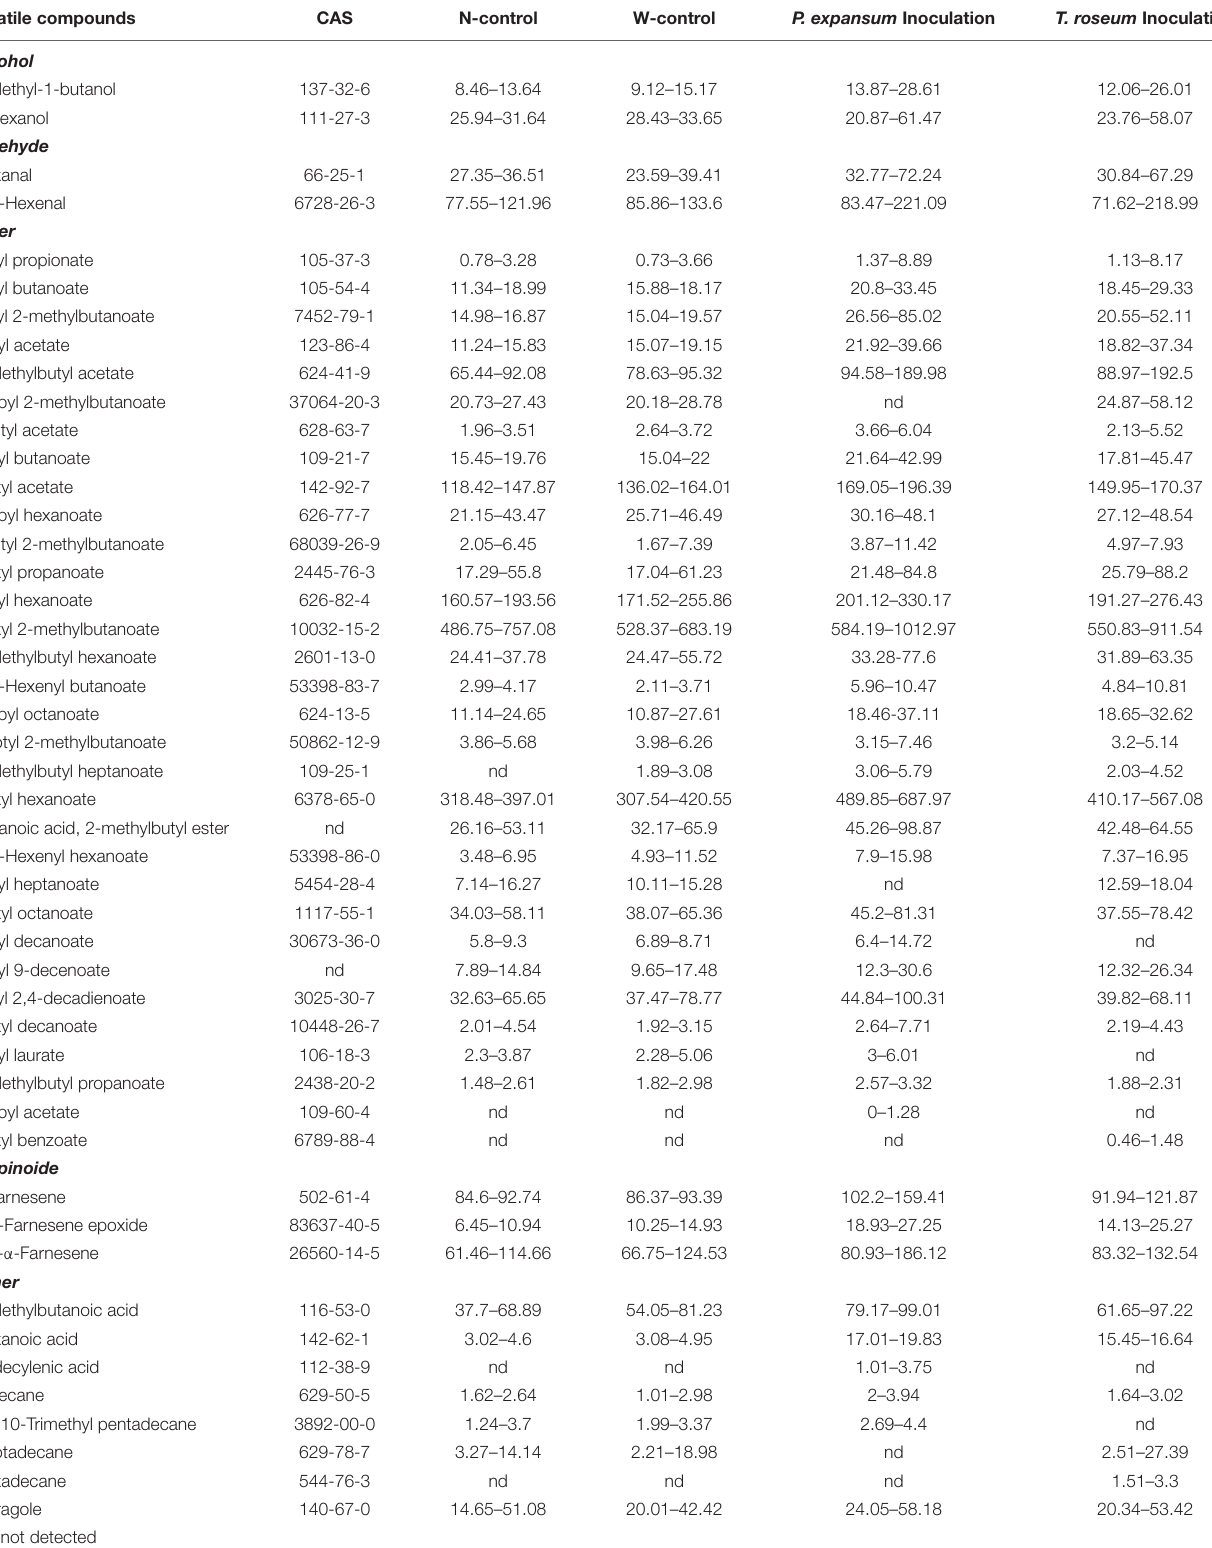
TABLE 1 | Minimum and maximum contents of volatile compounds ( µ g g − 1 ) detected in the two apple cultivars during shelf-life at 20 ◦